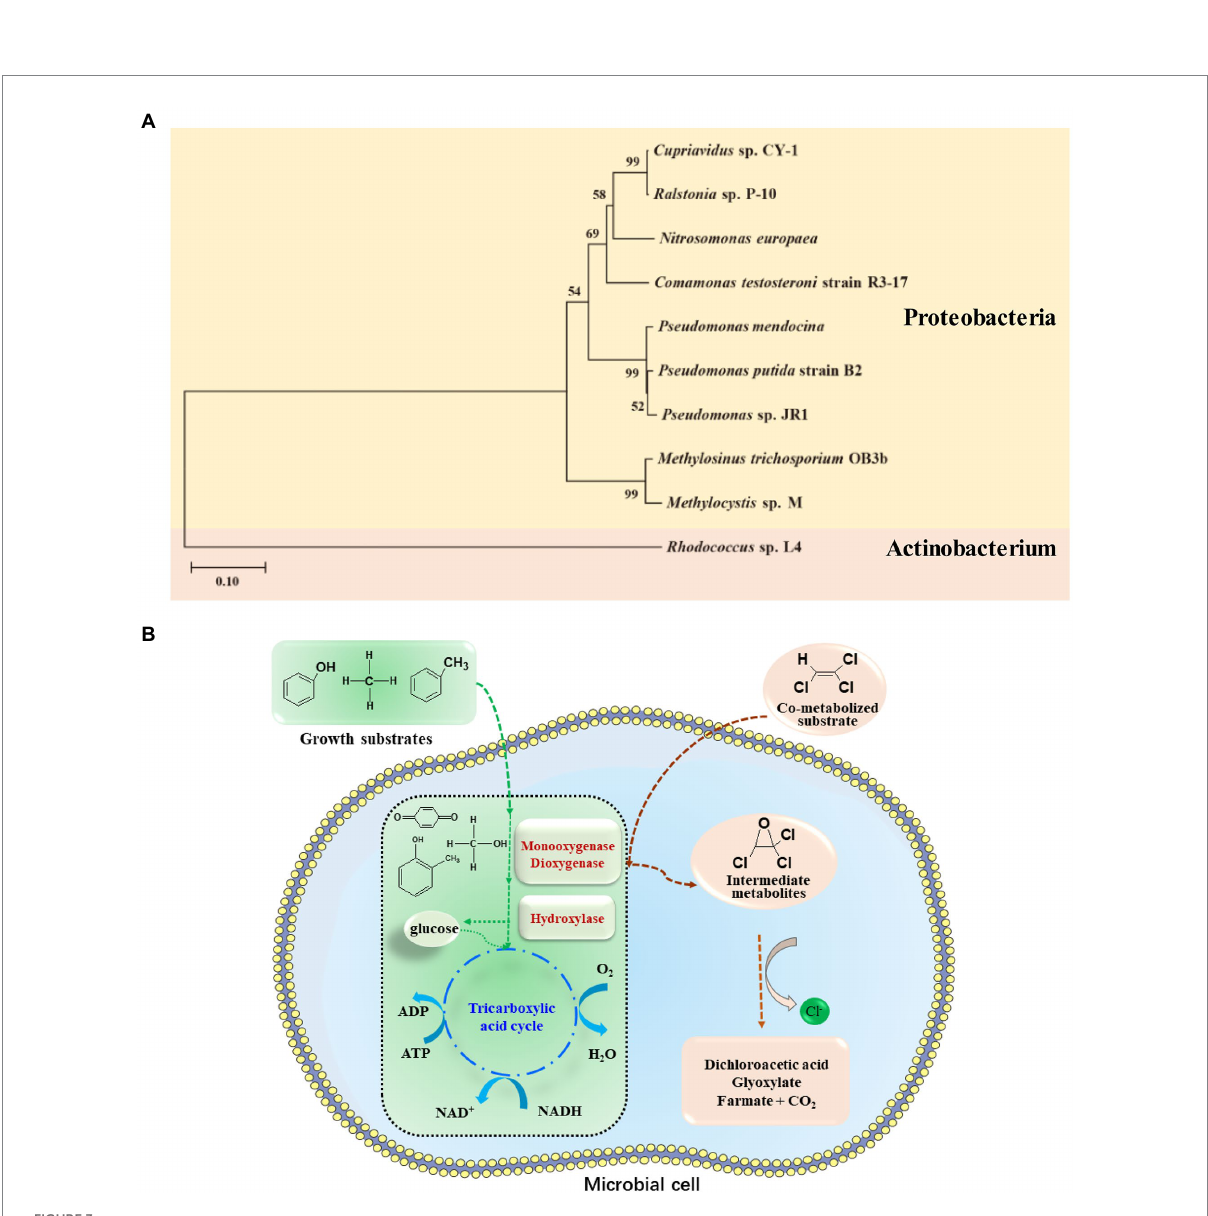
FIGURE 3 (A) Phylogenetic tree constructed based on the 16S rRNA sequences of isolated bacteria for TCE aerobic co-metabolism degradation; (B) Conceptual diagram of mechanism of aerobic co-metabolism of TCE with toluene, methane, and